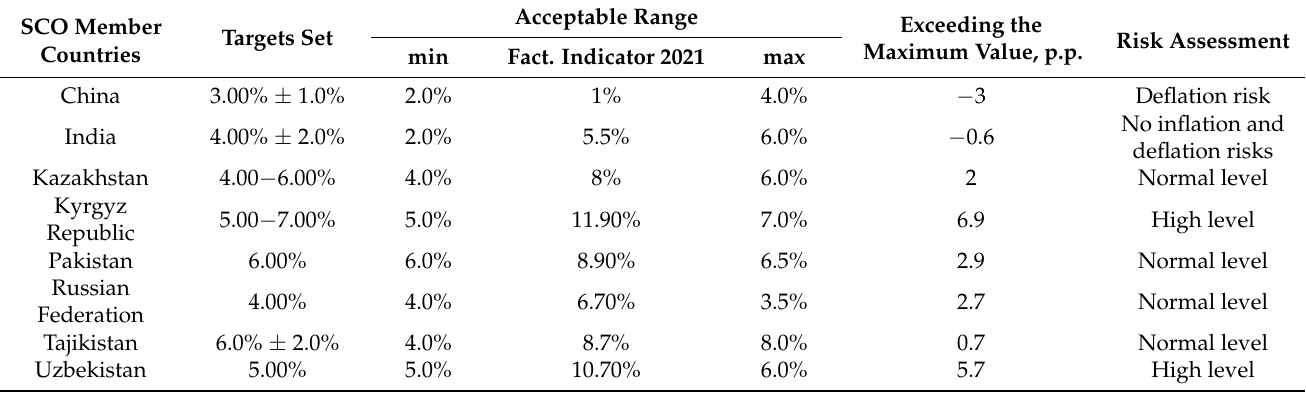
Table 2. Inflation rates in the SCO member countries in